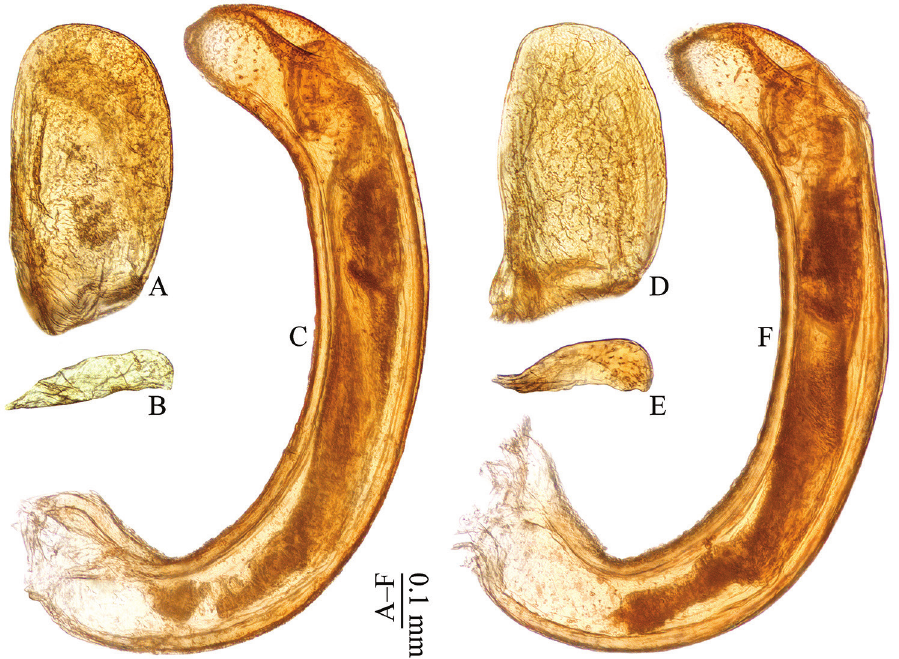
Figure 6. Aedeagi of Omoglymmius ( s. str. ) spp. A–C Omoglymmius ( s. str. ) laticeps Bell, 1977 (Bhutan: Thimphu) D–F Omoglymmius ( s. str. ) wukong sp. n. (paratype, ♂ ) A, D left parameres B, E right para- meres C, F median lobes. ( A, D dorsal view B, C, E, F right lateral